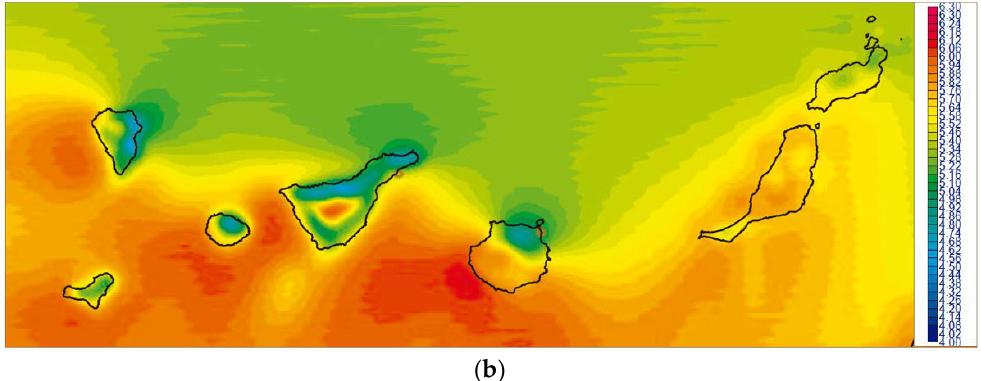
Figure 14. Radiation solar map: ( a ) Iberian Peninsula and ( b ) Canary Island. The values in the color bars are the average annual radiation solar, in kWh/m 2 day (Reproduced with permission from [75]. Aemet, 2019). Table 7. Radiation solar values, in kWh/m 2 day in all the areas in the Spanish coast . Area Zone